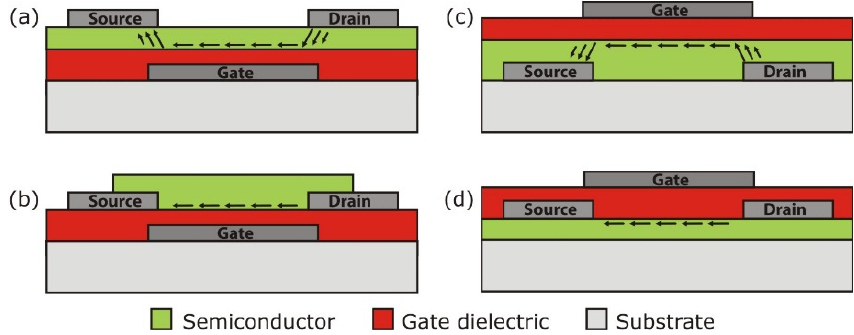
Figure 2. General thin-film transistor configurations: ( a ) staggered bottom-gate; ( b ) coplanar bottom-gate; ( c ) staggered top-gate and ( d ) coplanar